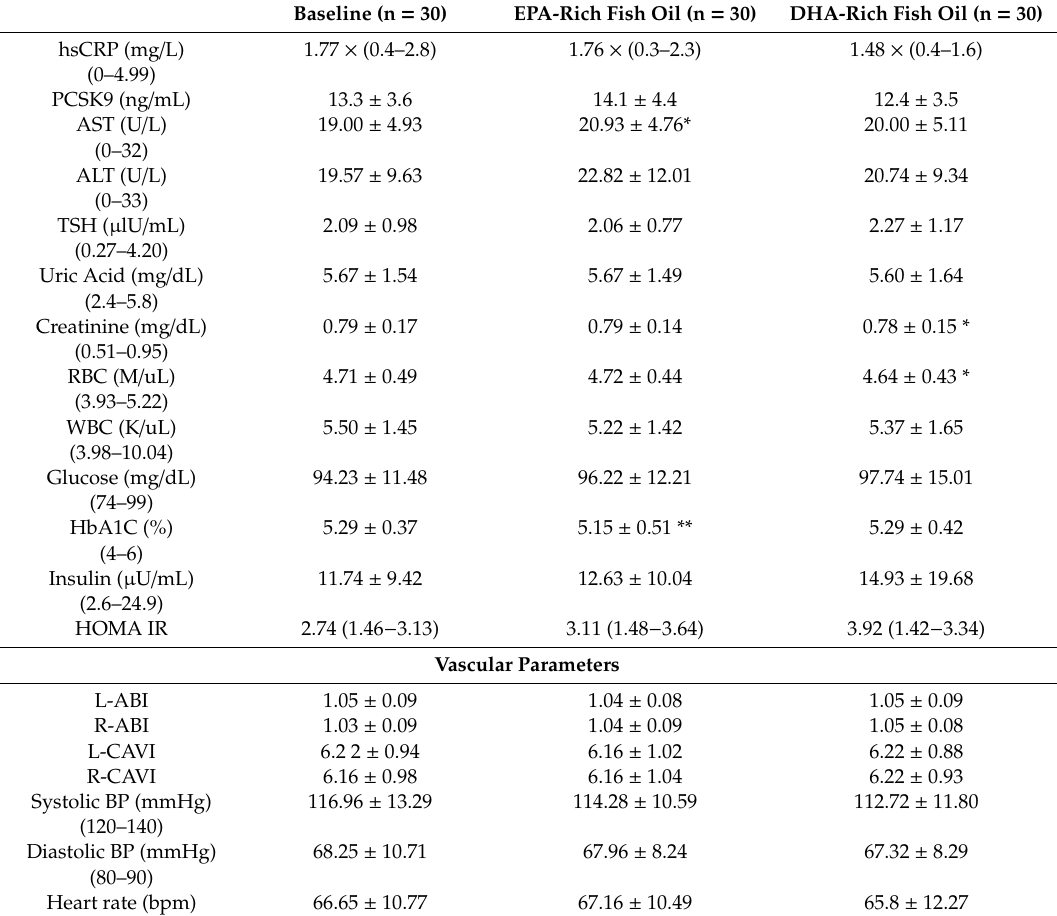
Table 7. Various biomarkers for CVD before (baseline) and after a 8-week ingestion of EPA-rich or DHA-rich fish oil